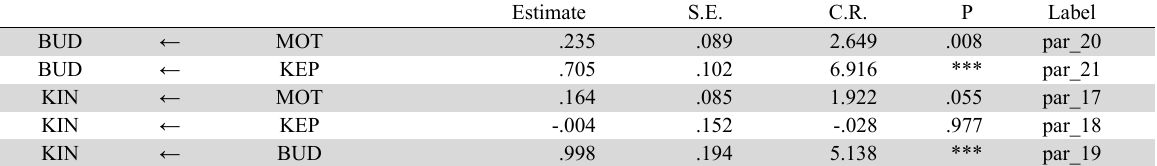
0.977 <2. Regression Weight (Lambda) of Leadership (KEP), Organizational Culture (BUD) and Performance Indicators (KIN)